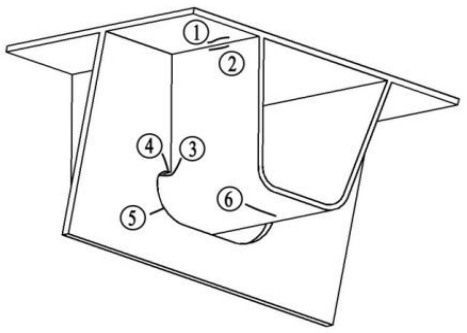
Figure 3. Typical fatigue details of steel bridge